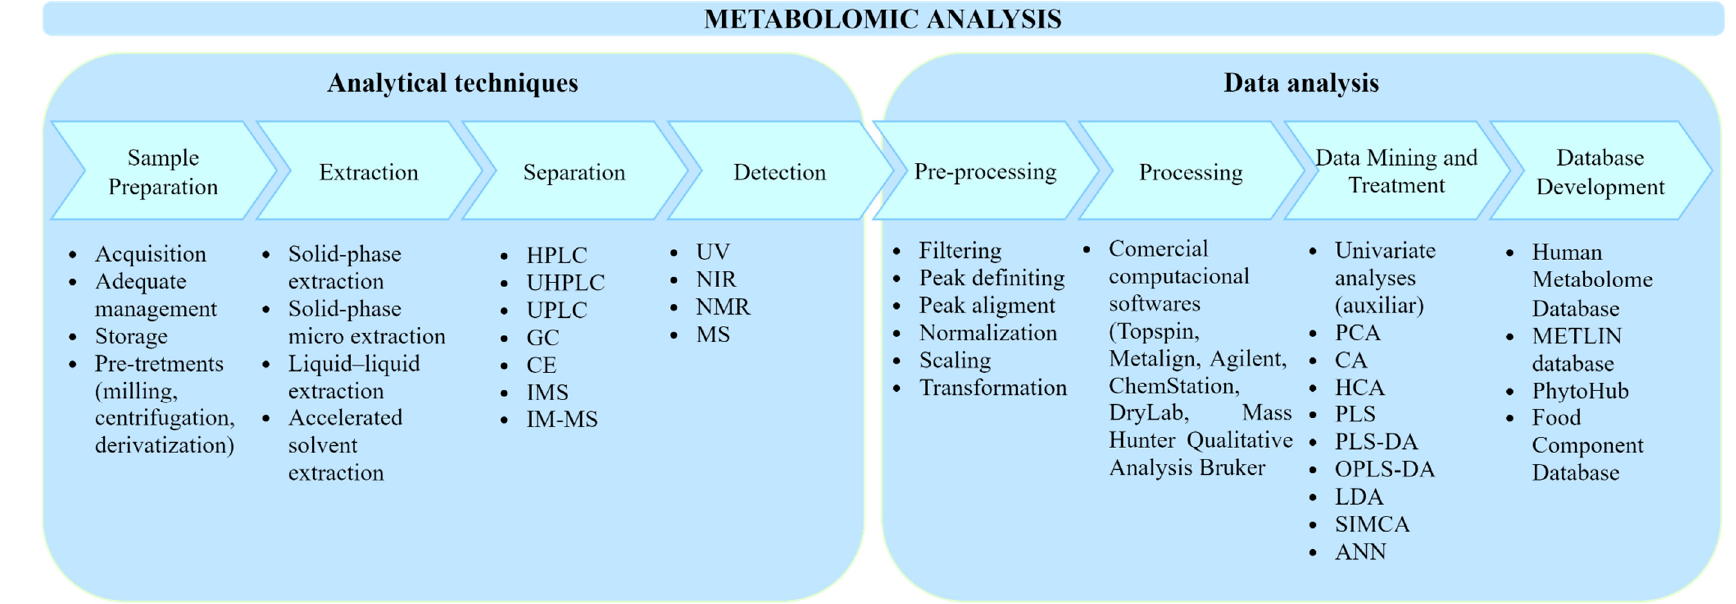
Figure 2. Basic workflow of metabolomic analysis.